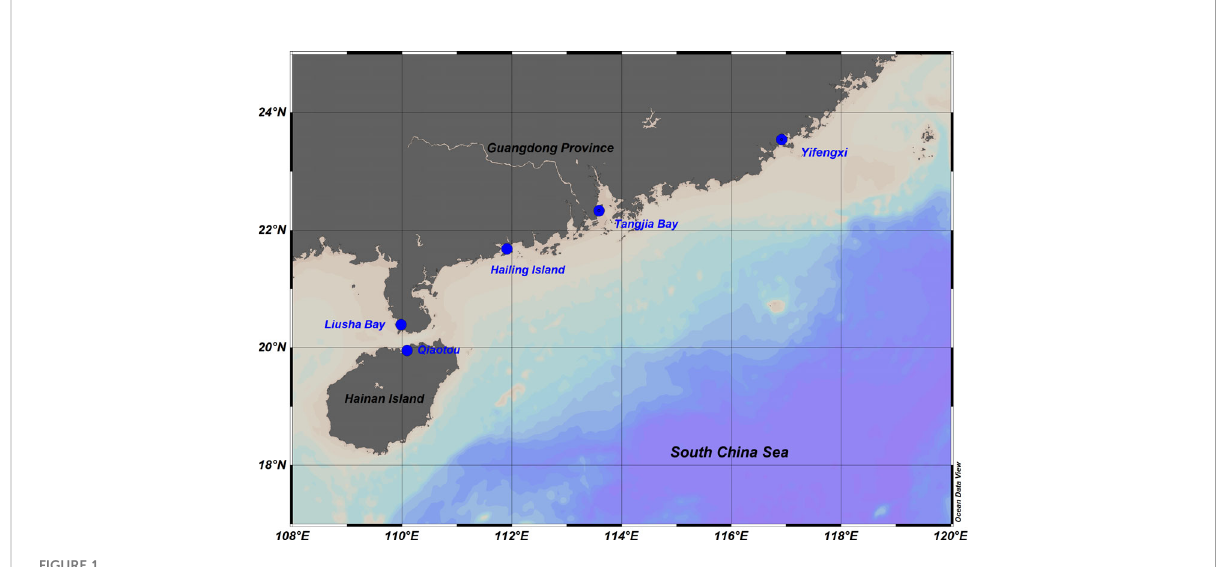
FIGURE 1 Sampling sites along the coast of Guangdong province and Hainan